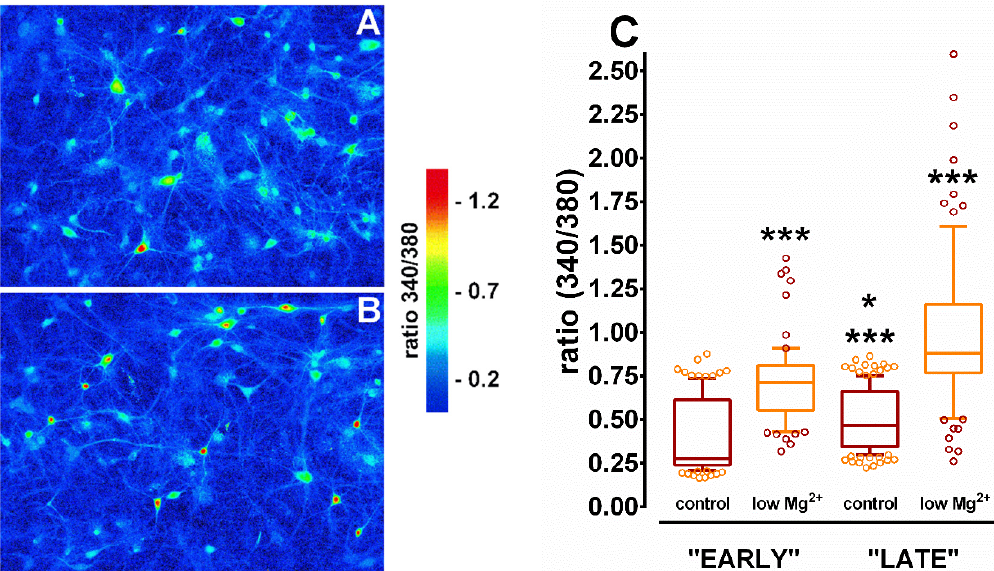
Figure 6. Changes in [Ca 2+ ] i in hippocampal neurons during SE. Culture dishes were incubated in control or low Mg 2+ solutions and [Ca 2+ ] i levels were determined using the fluorescent Ca 2+ binding dye fura-2 AM and standard Ca 2+ imaging techniques described in Materials and